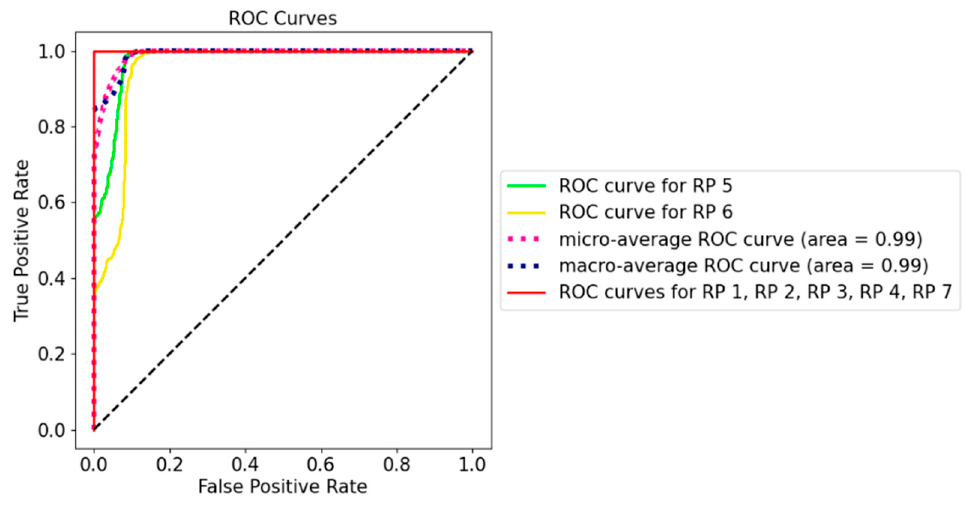
Figure 9. ROC curve for Dataset 6 using AP1 (the Synology AP).